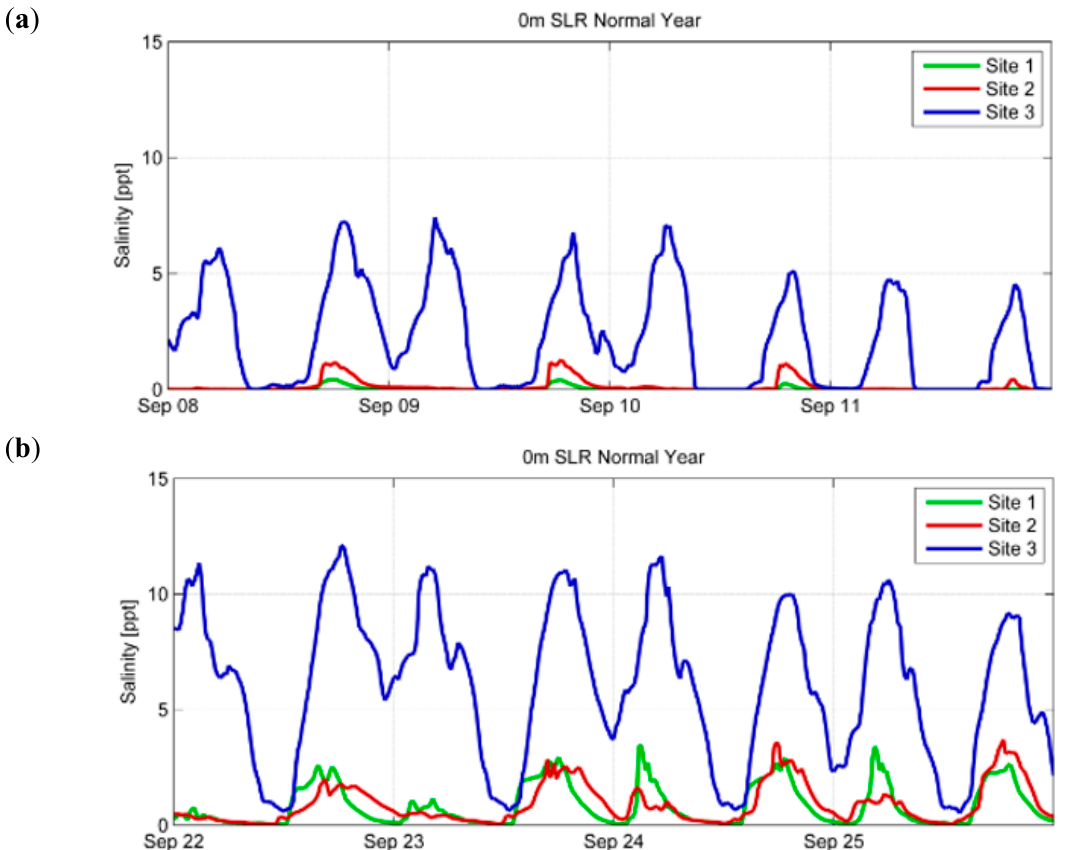
Figure 12. Modelled surface salinity at site 1, site 2, and site 3 in September: ( a ) 8–11 September; ( b ) 22–25 September.